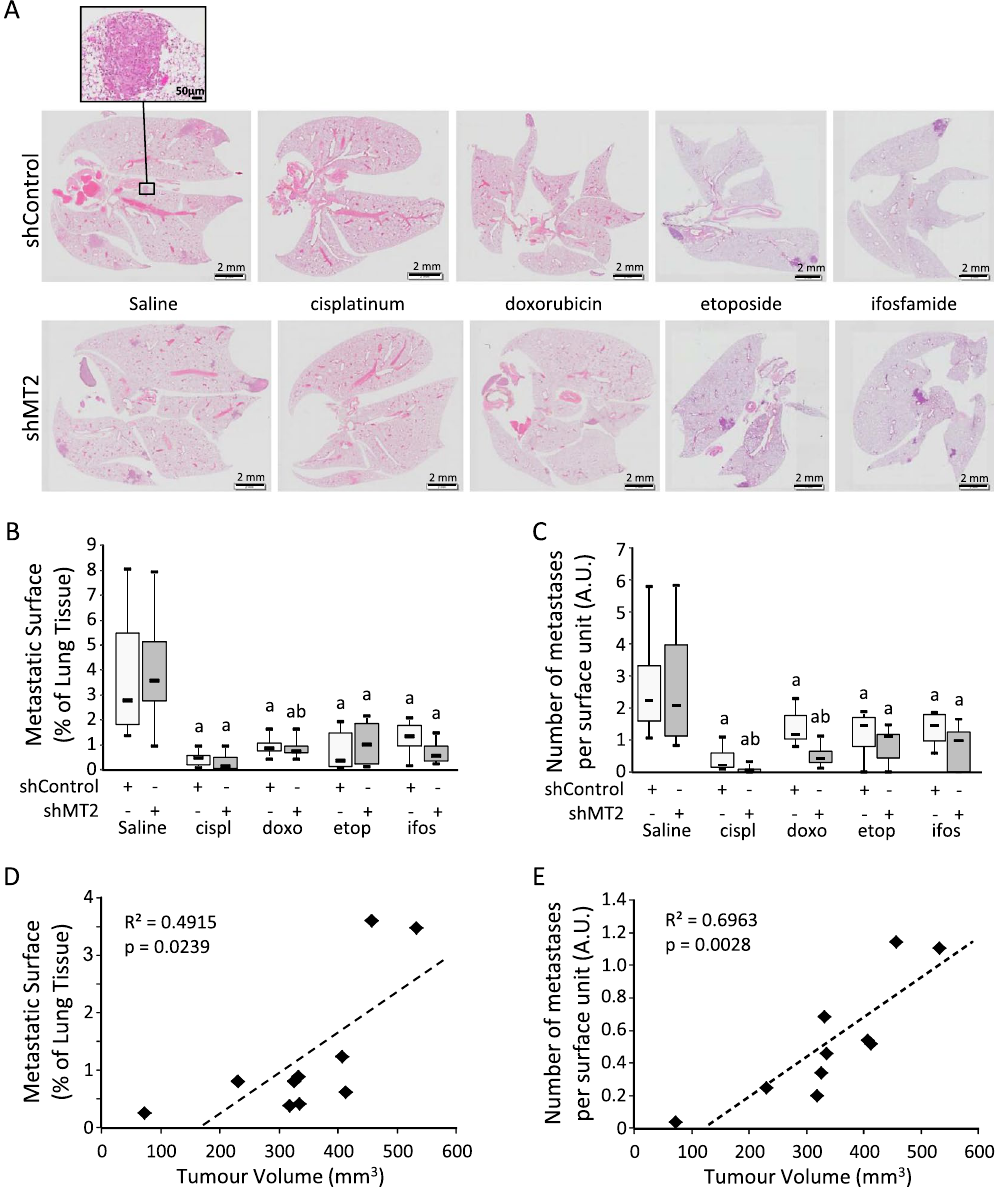
Figure 6. Silencing of MT2 influences chemotherapy tumour pulmonary metastatic dissemination. K7M2 cells modified with shControl or shMT2 were injected intramuscularly into the thighs of SCID mice and administered with chemotherapy as described in the Methods section. ( A ) H&E staining of lung tissue sections. The scale bars represent 2 mm, except in the upper-left insert: Scale bar = 50 µ m. ( B ) Boxplot specifying the metastatic surface. Results are expressed as percent of whole pulmonary tissue. a indicates a statistically significant difference vs . saline ( p < 0.05); b indicates a statistically significant difference vs . shControl group (p < 0.05). ( C ) Boxplot specifying the number of metastatic nodules per field. a indicates a statistically significant difference vs . saline ( p < 0.05); b indicates a statistically significant difference vs . shControl group (p < 0.05). ( D ) Spearman correlations between the relative metastatic surface, as expressed as percent of whole pulmonary tissue, and tumour volume as expressed as mm 3 . The black line shows the regression